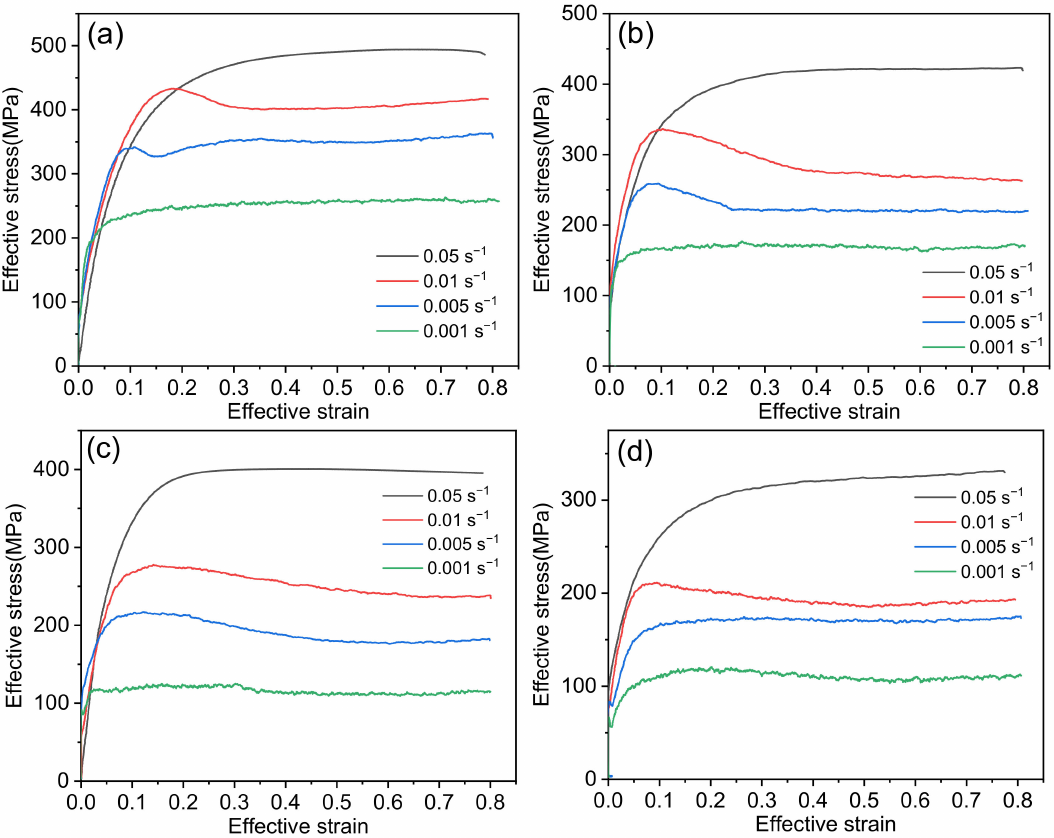
Figure 3. Stress–strain curves of Inconel 625 of 0.7 at ( a ) 950 ◦ C, ( b ) 1000 ◦ C, ( c ) 1050 ◦ C, ( d ) 1100 ◦